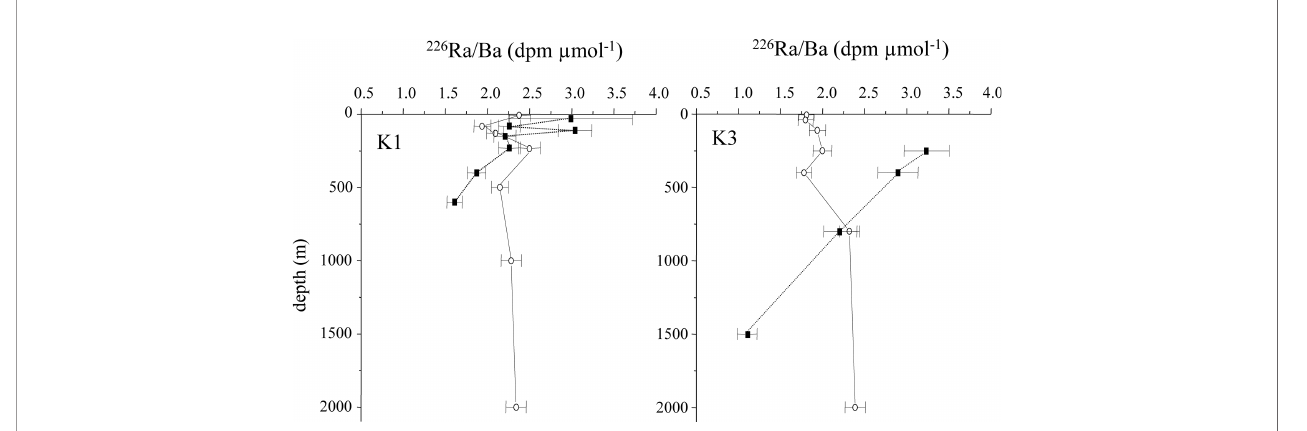
FIGURE 6 | Vertical pro fi les of 226 Ra/Ba ratios determined at stations K1 and K3 in suspended particles (black squares) and in seawater (open